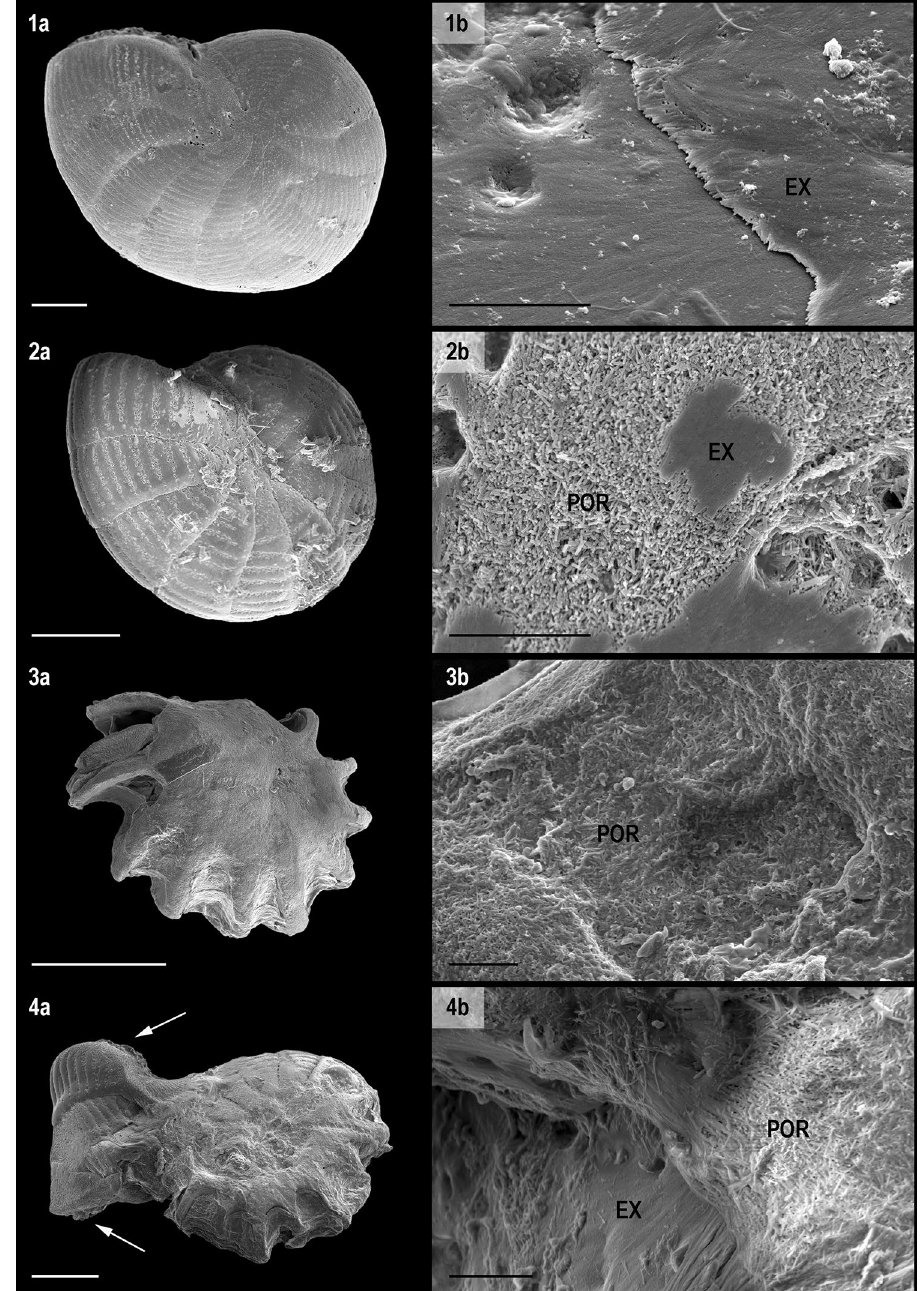
Figure 2. E-SEM micrographs of Peneroplis spp. Left: general views, scale bars are 100 µm. Right: magnified views, scale bars are 5 µm. Three days at ( 1 ) pH 7.9; ( 2 ) pH 7.4; ( 3 ) pH 6.9. ( 4 ) 32 days at pH 7.4 + 15 days at pH 7.9. POR porcelain, EX extrados. Arrows: